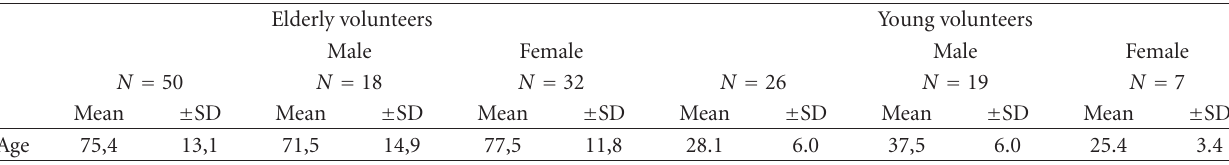
Table 1: Demographic data of elderly and young